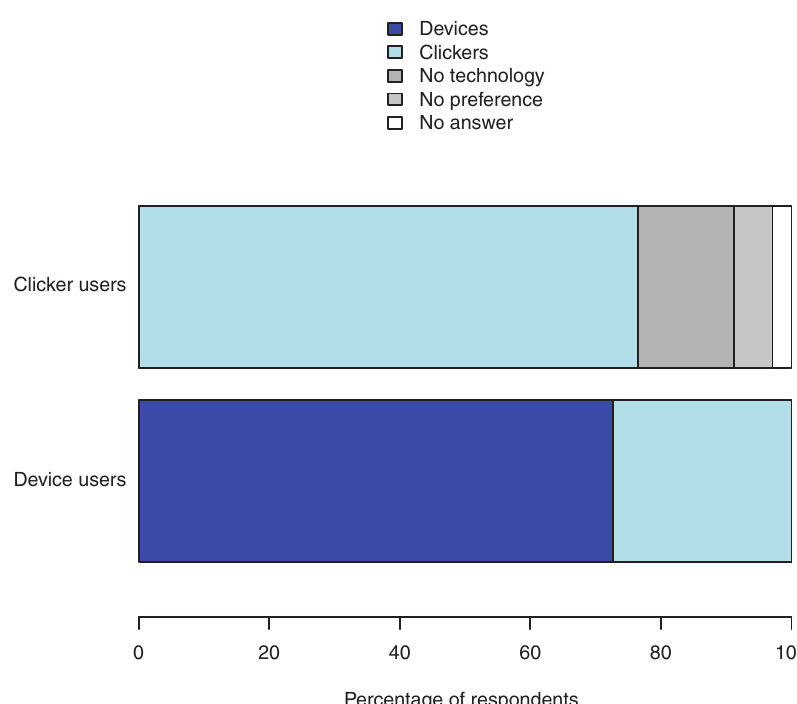
Figure 3. Preferences for different lecture types. The proportion of students who preferred lectures using their personal devices, clickers, and no interactive technology, by the type of response system they used in the device lectures (personal devices or